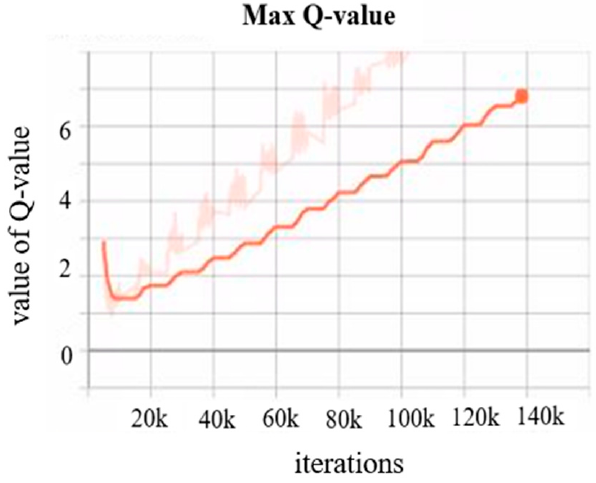
Figure 34. The maximum Q-value.